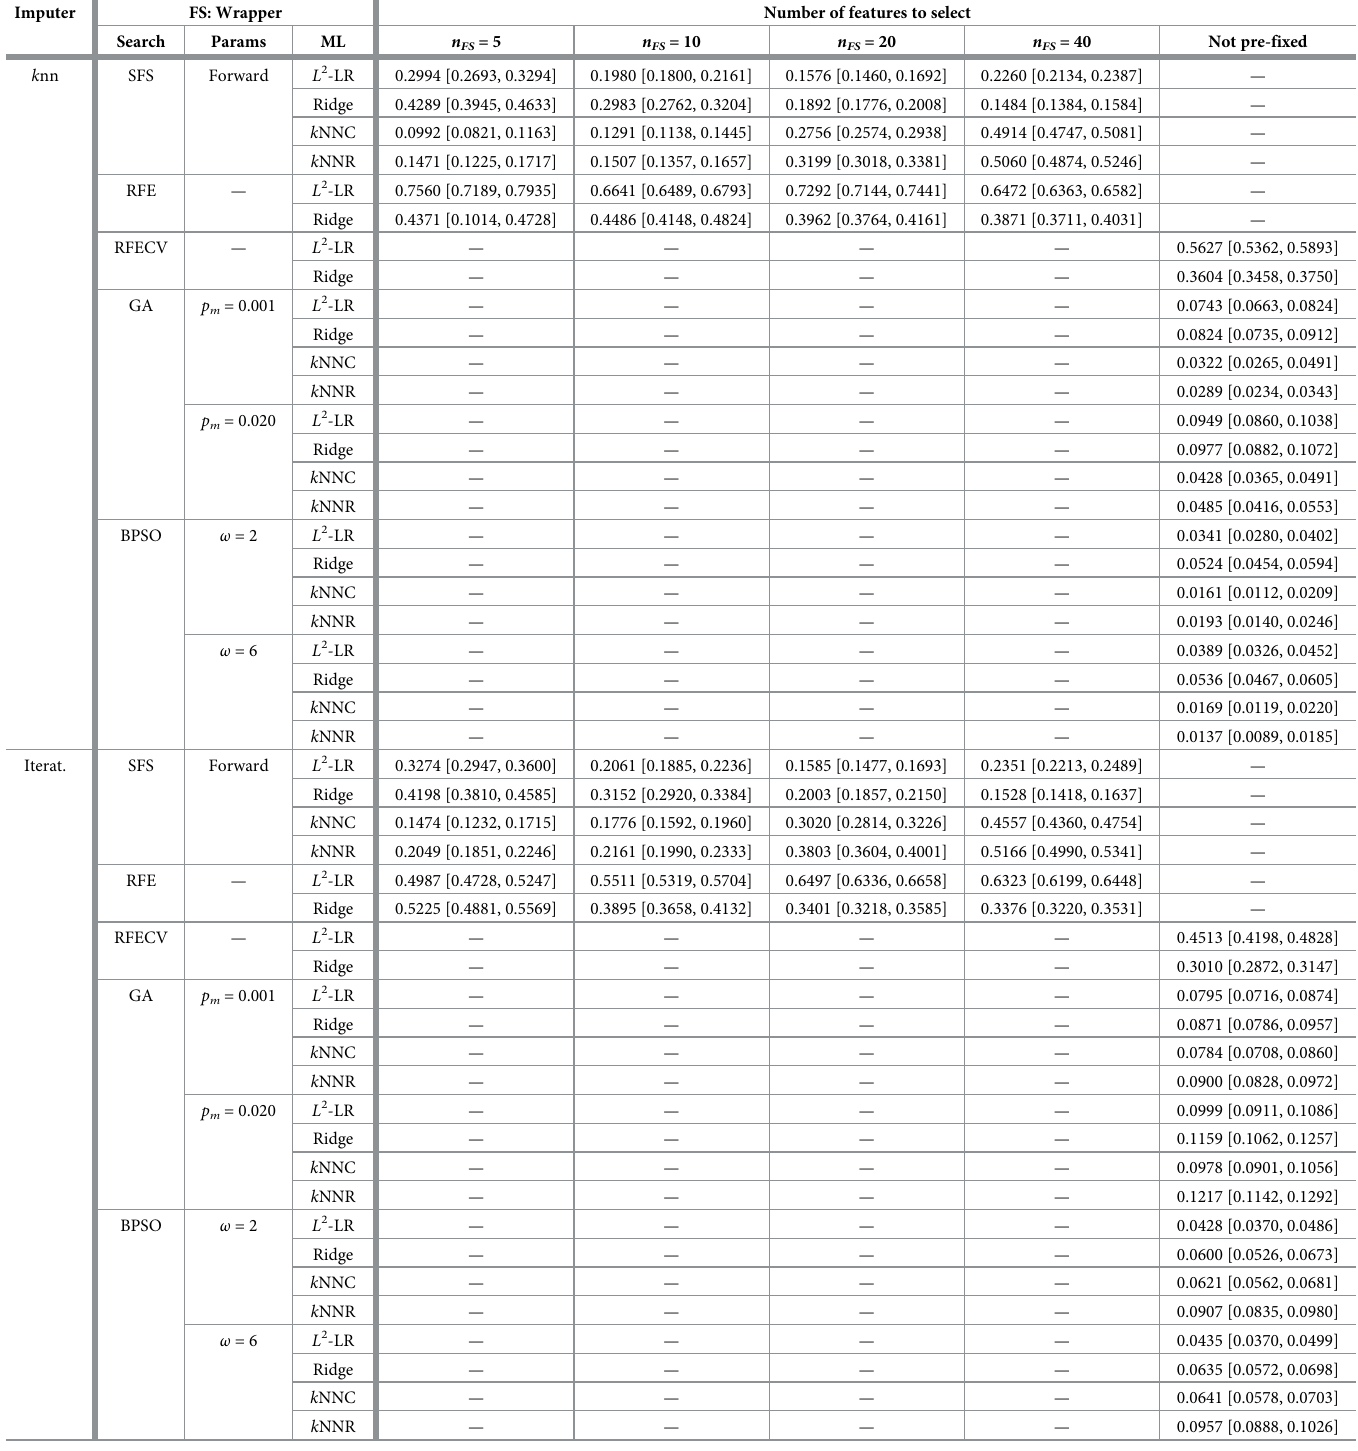
Table 3. Stability for the wrapper algorithms. Mean and 95%